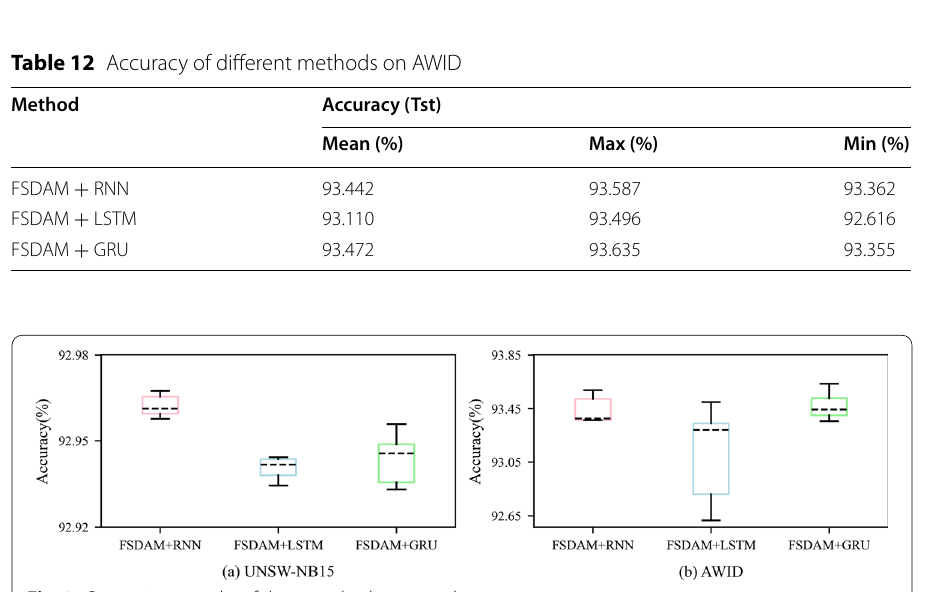
Fig. 9 Comparison results of three methods on two data